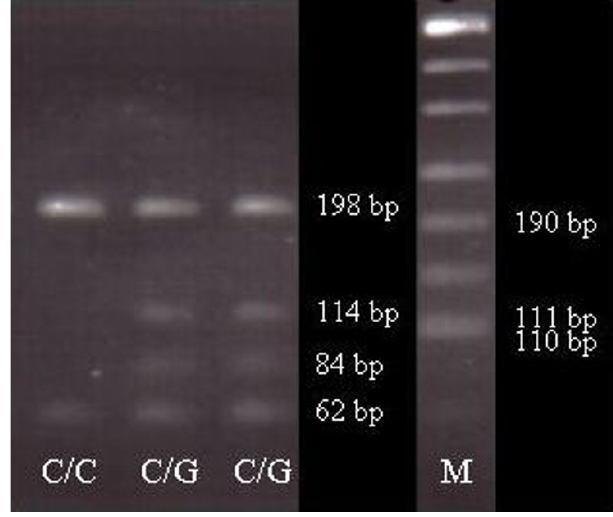
Figure 1 Restriction fragment length polymorphism (RFLP) analysis of PTPRC exon 4 77C → G; M=pUC19 DNA marker (501, 489, 404, 331, 242, 190, 147, 111, 110, 67